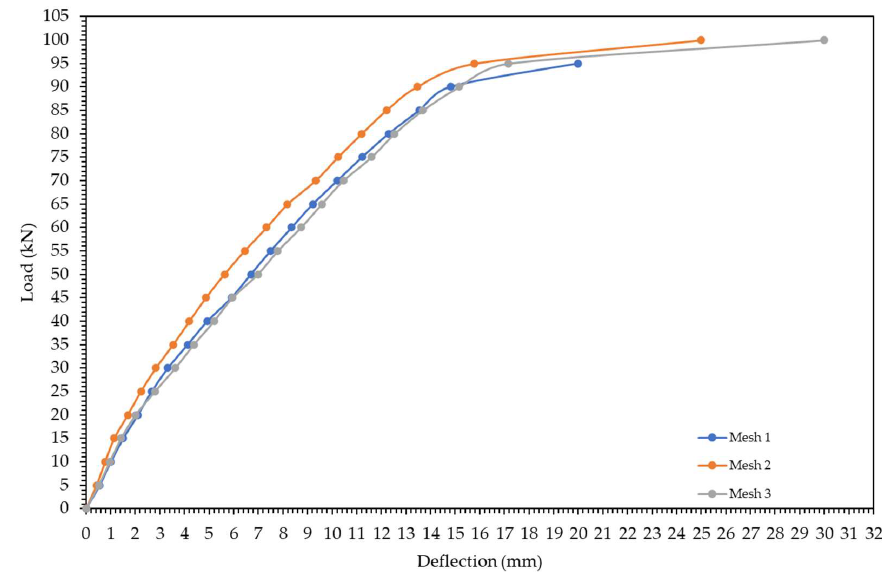
Figure 14. Load-Deflection Graph for Mesh Reinforced